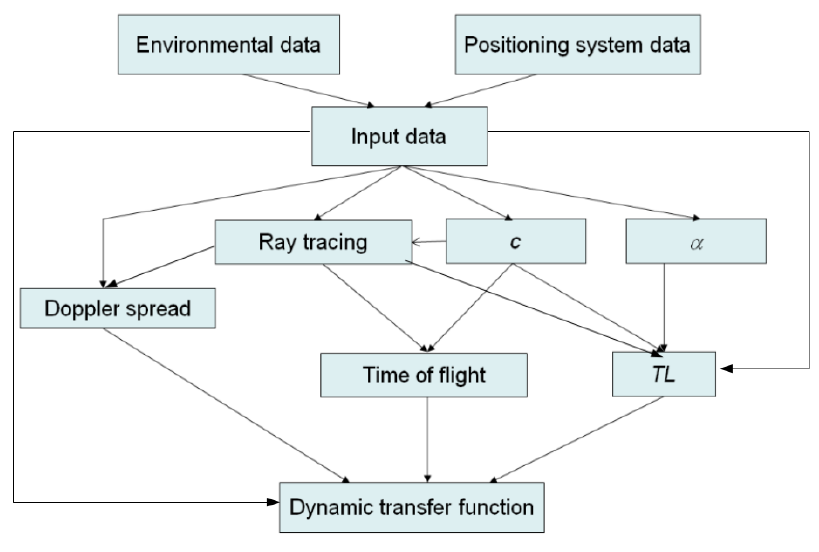
Figure 1. Block diagram of the propagation